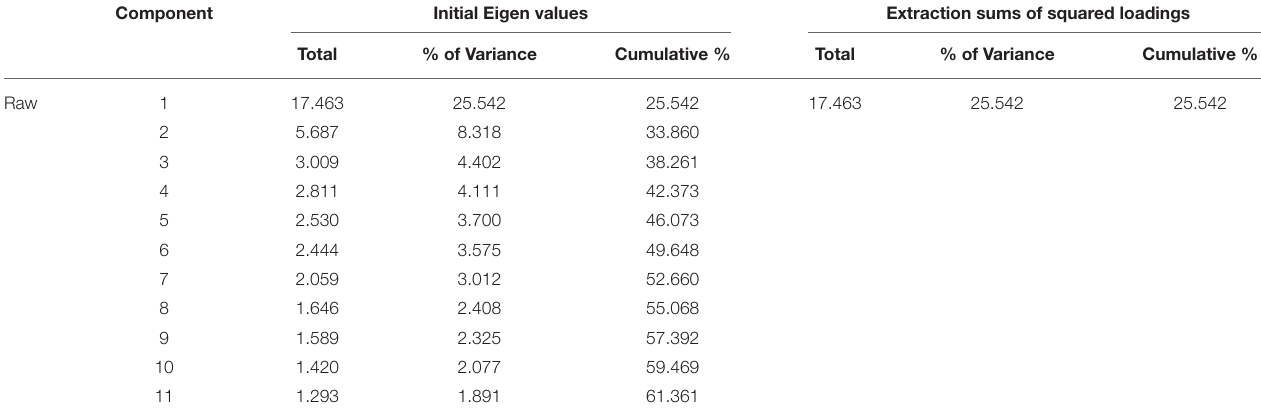
TABLE 4 | Total variance explained.